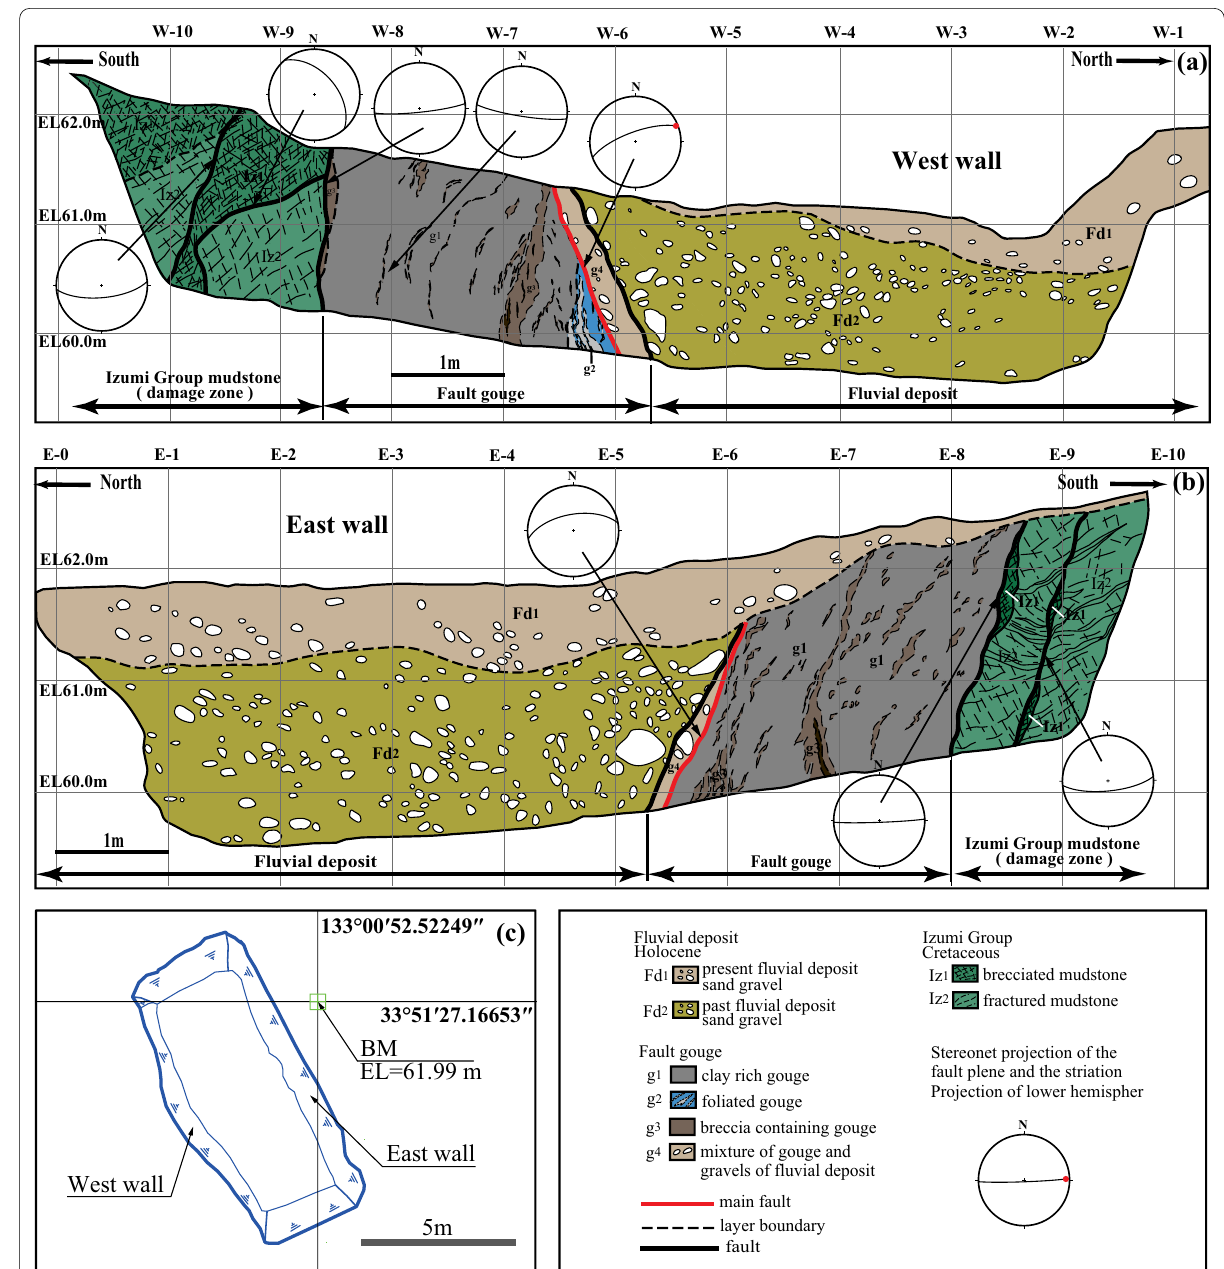
Fig. 2 Logs of the Kawakami Fault on the trench wall (Fig. 1c, loc. 5). a Logs of the west wall, and b log of the east wall. c The survey map shows a trench site and a benchmark (BM) at the Yuyaguchi